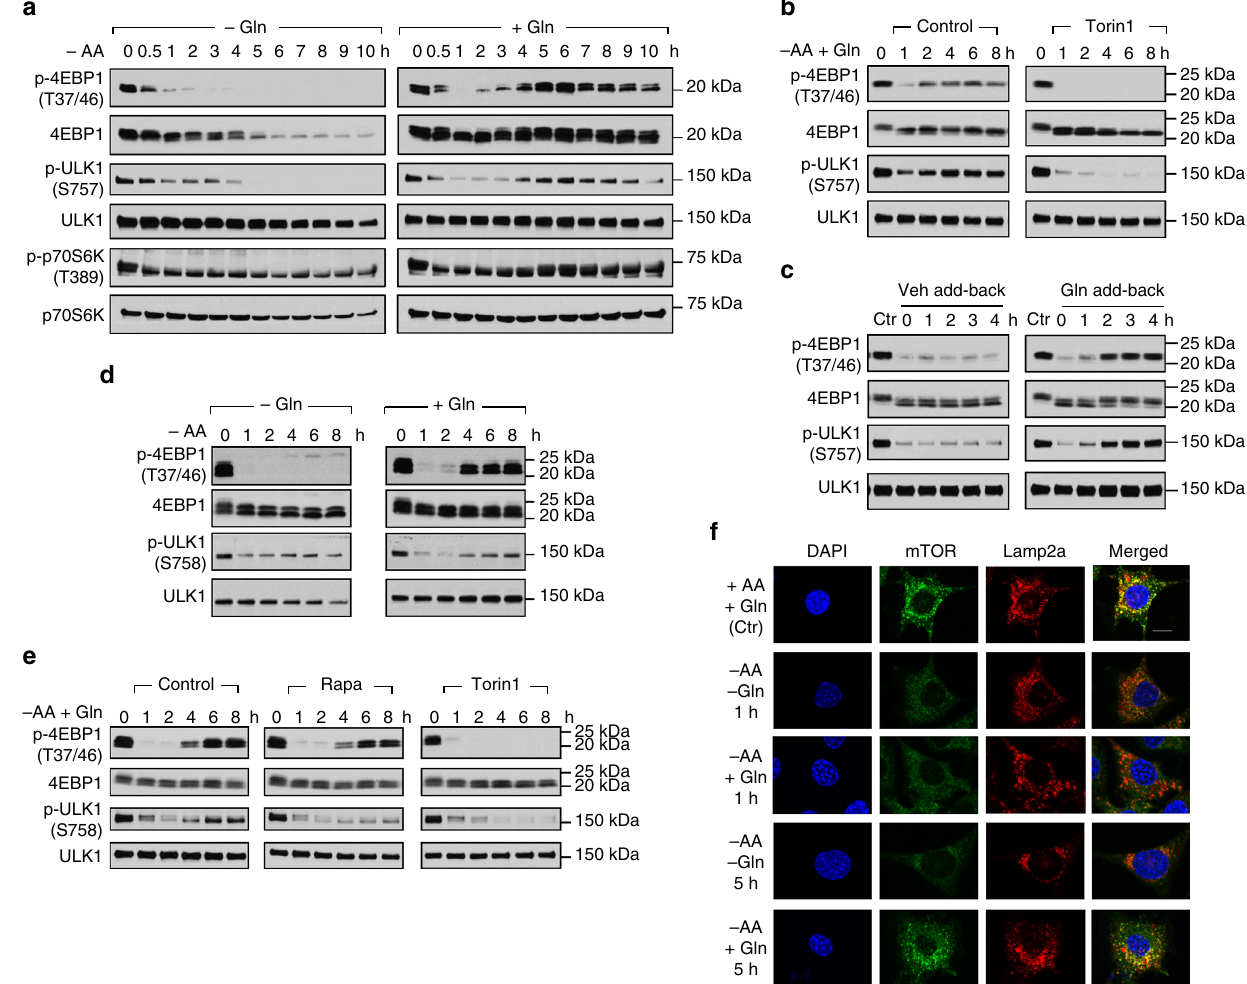
Fig. 1 Glutamine reactivates mTORC1 signaling during amino acid starvation. a Wild-type MEFs were starved of amino acids with or without the supplementation of glutamine (4 mM) for the indicated durations. Changes in mTORC1 signaling were assessed by immunoblotting of p-4EBP1, p-ULK1, and p-p70S6K. b Wild-type MEFs were deprived of amino acids with the supplementation of glutamine (4 mM) for the indicated durations. Torin 1 (250 nM) was added upon induction of amino acid starvation to inhibit mTORC1. c Wild-type MEFs were deprived of amino acids for 5 h and cells were treated with H 2 O (vehicle add-back) or 4 mM glutamine (Gln add-back) for the indicated durations. d HepG2 cells were subjected to amino acid starvation in the absence or presence of glutamine (4 mM) for the indicated durations. e HepG2 cells were starved of amino acids with the supplementation of glutamine (4 mM) for the indicated durations. Rapamycin (50 nM) or Torin 1 (250 nM) was added upon induction of starvation to inhibit mTORC1. Changes in mTORC1 activity were assessed by immunoblotting of p-4EBP1 and p-ULK1. f Wild-type MEFs were starved of amino acids with or without the supplementation of glutamine (4 mM) for 1 or 5 h. Cells were then fi xed and co-stained with antibodies speci fi c for mTOR ( green ) and the lysosomal marker Lamp2a ( red ). The scale bar represents 10 µ